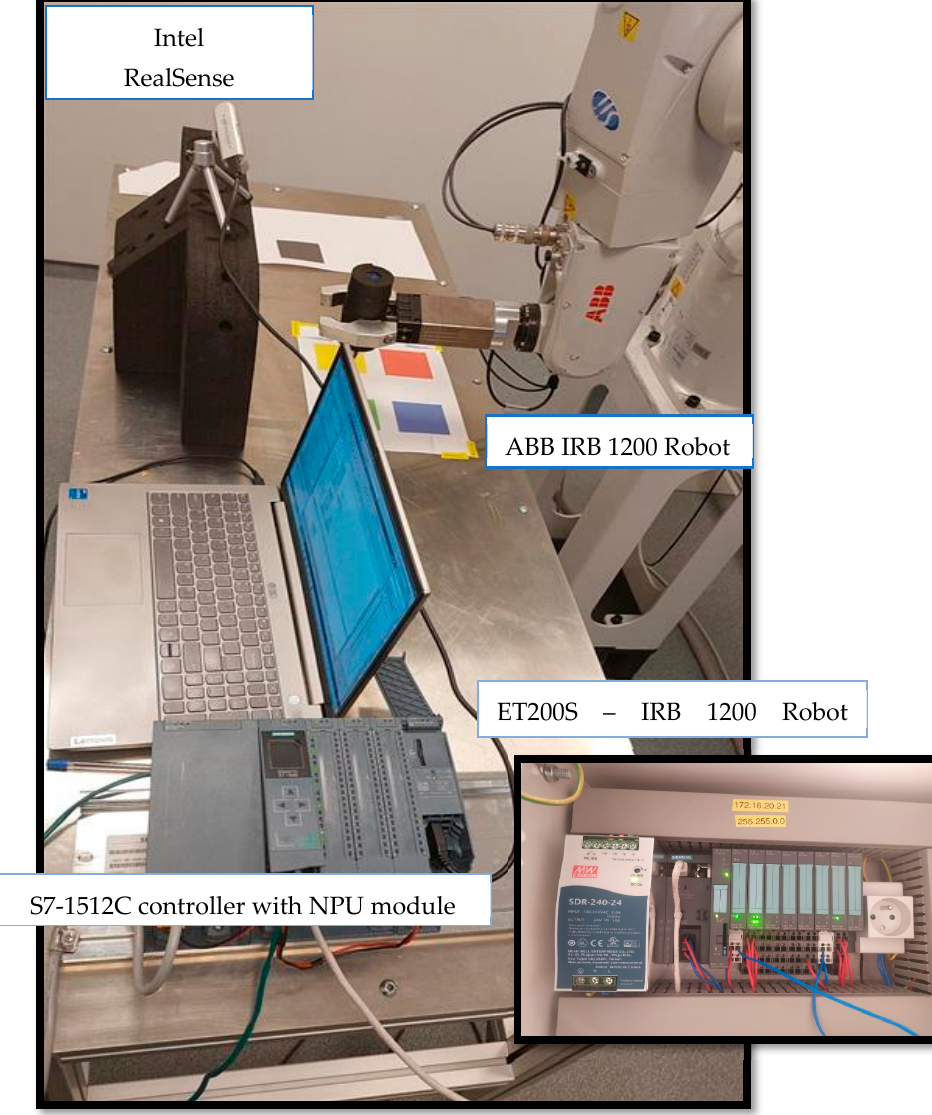
Figure 2. The testbed—an image recognition system based on two Siemens controllers, Intel RealSense camera, NPU module and IRB1200 robot.